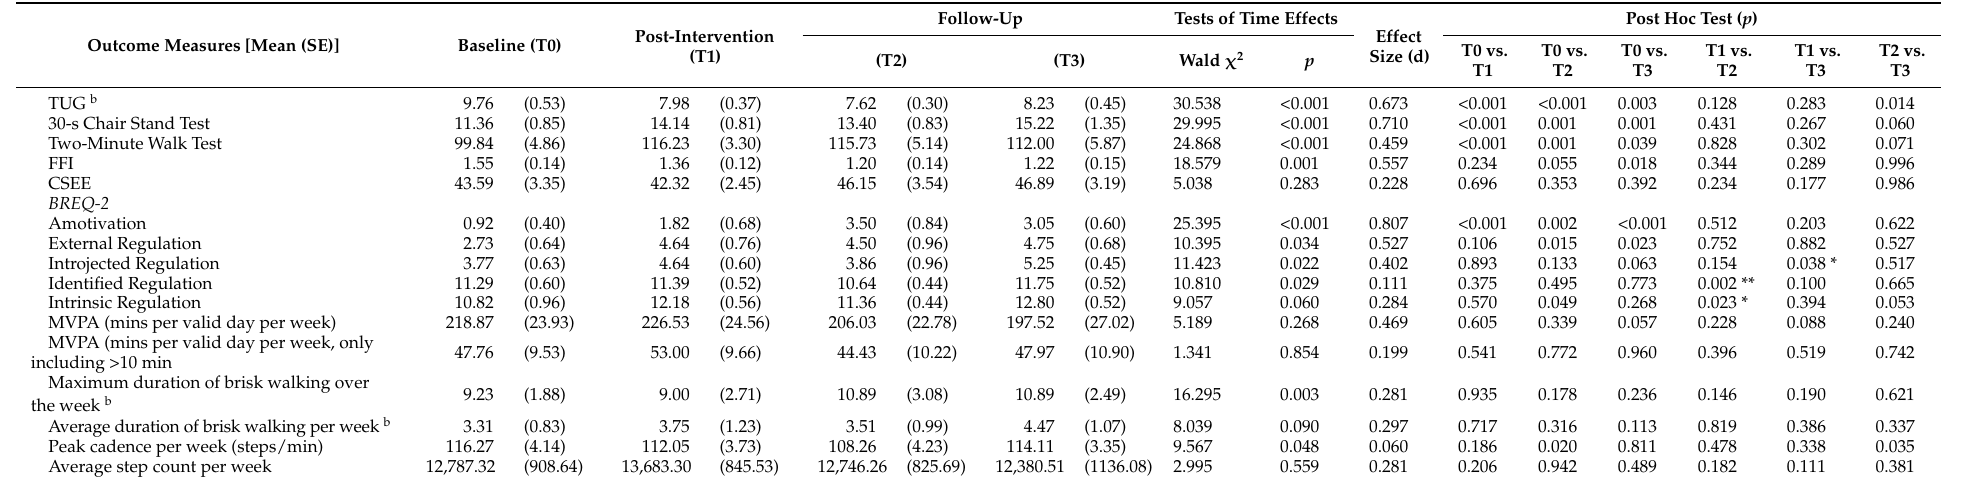
Table 6. Effectiveness of the intervention for the intervention group over time analyzed by GEE a